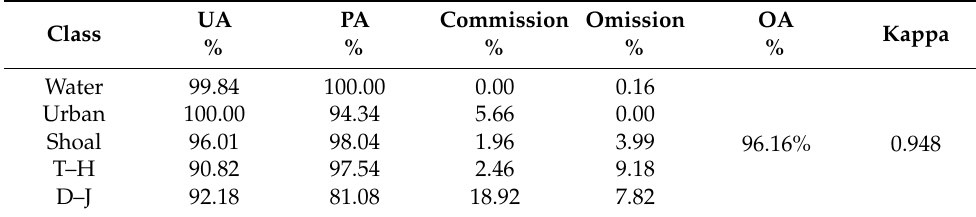
Table 3. Accuracy table of the classification. Class